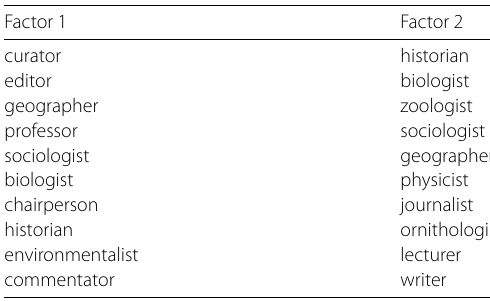
Table A1 Occupations with highest loadings, 2-factor solution, CC Factor